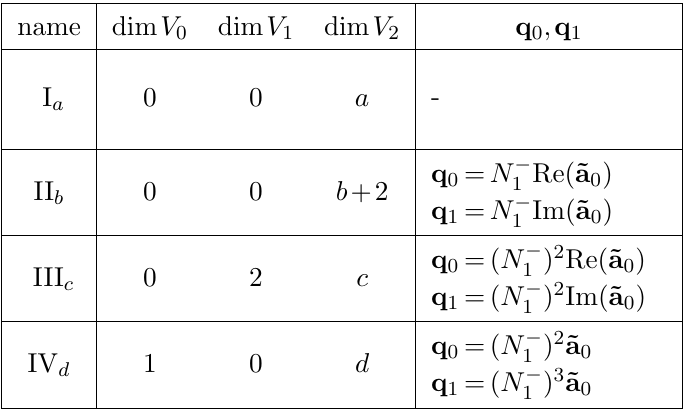
Table 2 . This table lists the dimensions of the spaces V ‘ for ‘ 2 E m = f 0 ; 1 ; 2 g for the possible one-parameter in(cid:12)nite distance limits. In addition, it includes the vectors that span the Type G charges for the charge vector Q G